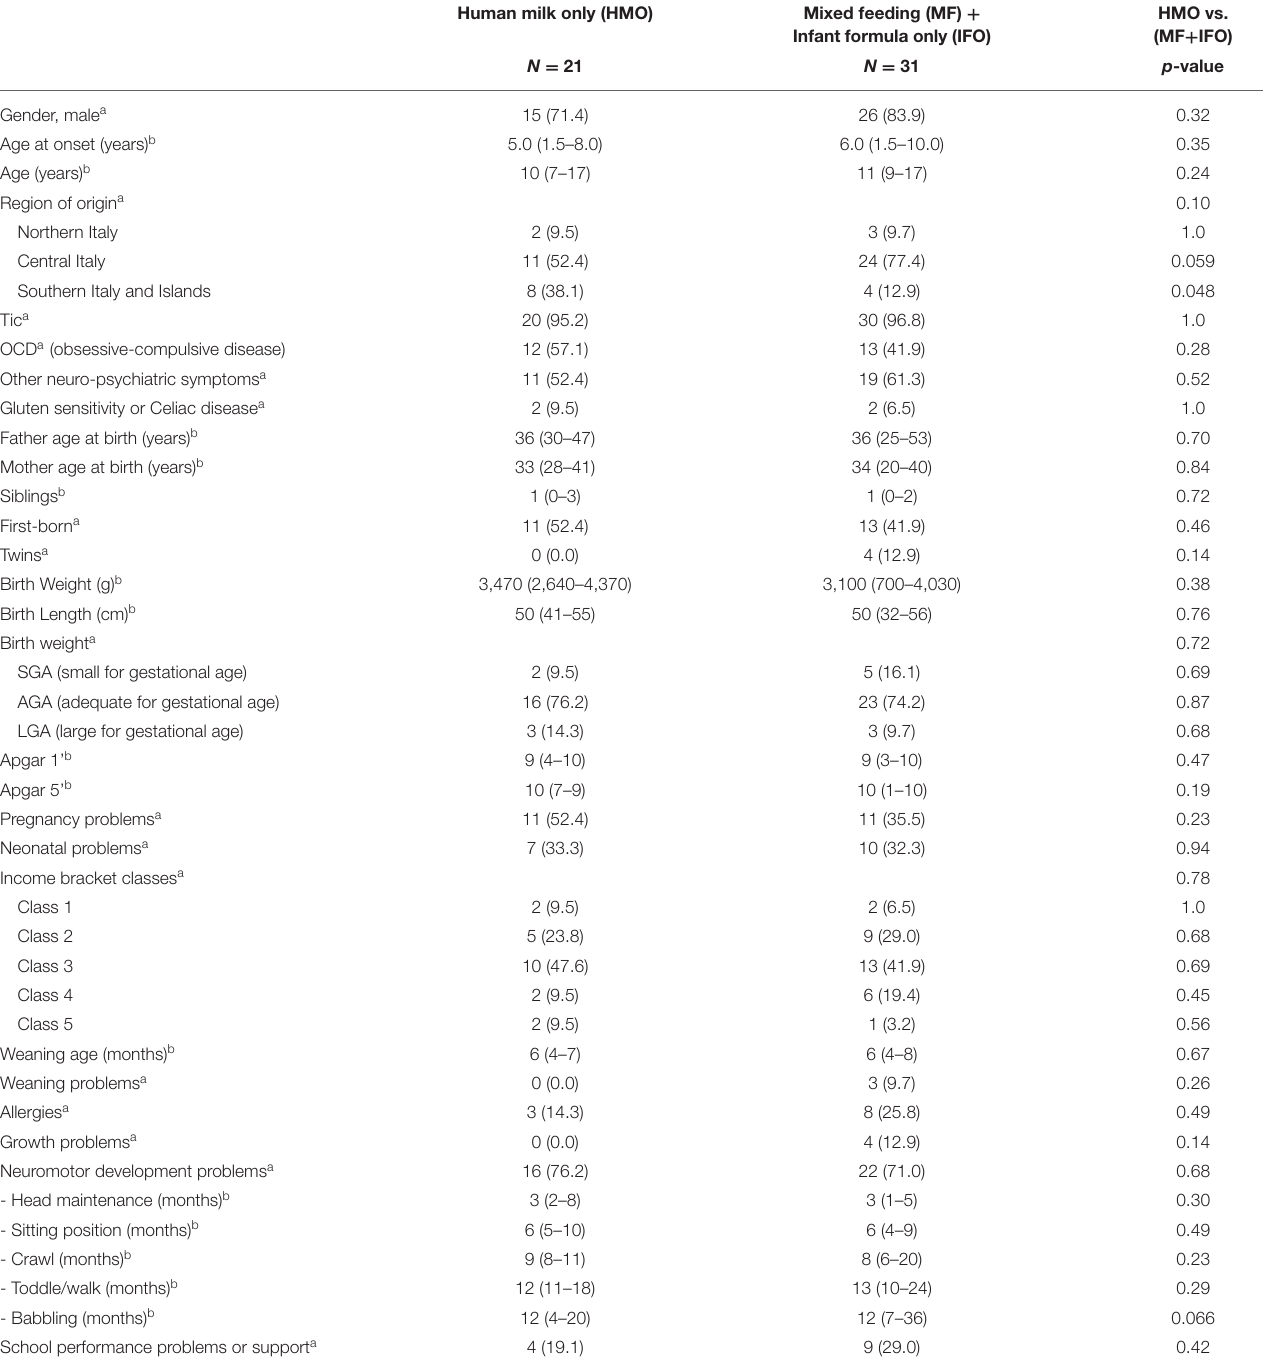
TABLE 3 | Comparison between the subgroups of the study cohort: HMO vs. MF + IFO groups.